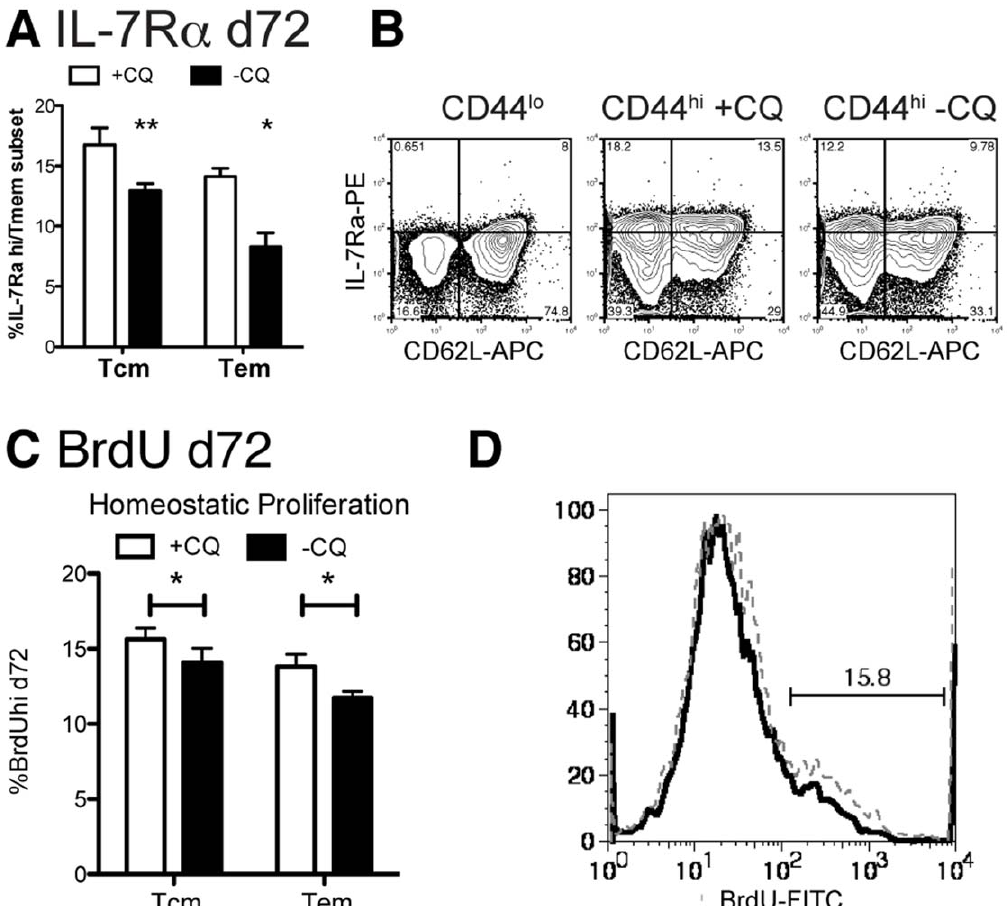
Figure 3. Chronic infection reduces IL-7R a hi memory cells in both memory subsets. Mice were infected with 10 5 P. chabaudi . Days 30–34 half of the mice were treated with chloroquine ( + CQ ), while the other mice retained a chronic infection ( -CQ ). 2.5 months after infection, splenocytes were analyzed by flow cytometry for CD4, CD44, CD62L and ( A, B ) IL-7R a (CD127) or incorporation of BrdU dosed into the water days 62–72 as an indicator of homeostatic proliferation, ( C, D ). Naı¨ve cells (CD44 lo ) were used as an internal control to set the quadrants ( B , left). Dotted lines represent chloroquine treated mice ( + CQ) while bold lines represent chronic infection (-CQ). Data shown is the average of 4–5 mice per group and experiment was repeated twice with similar results. Contour plots (10% with outliers) are gated as described on each plot and are from representative animals. * indicates p # 0.05, ** p # 0.01.